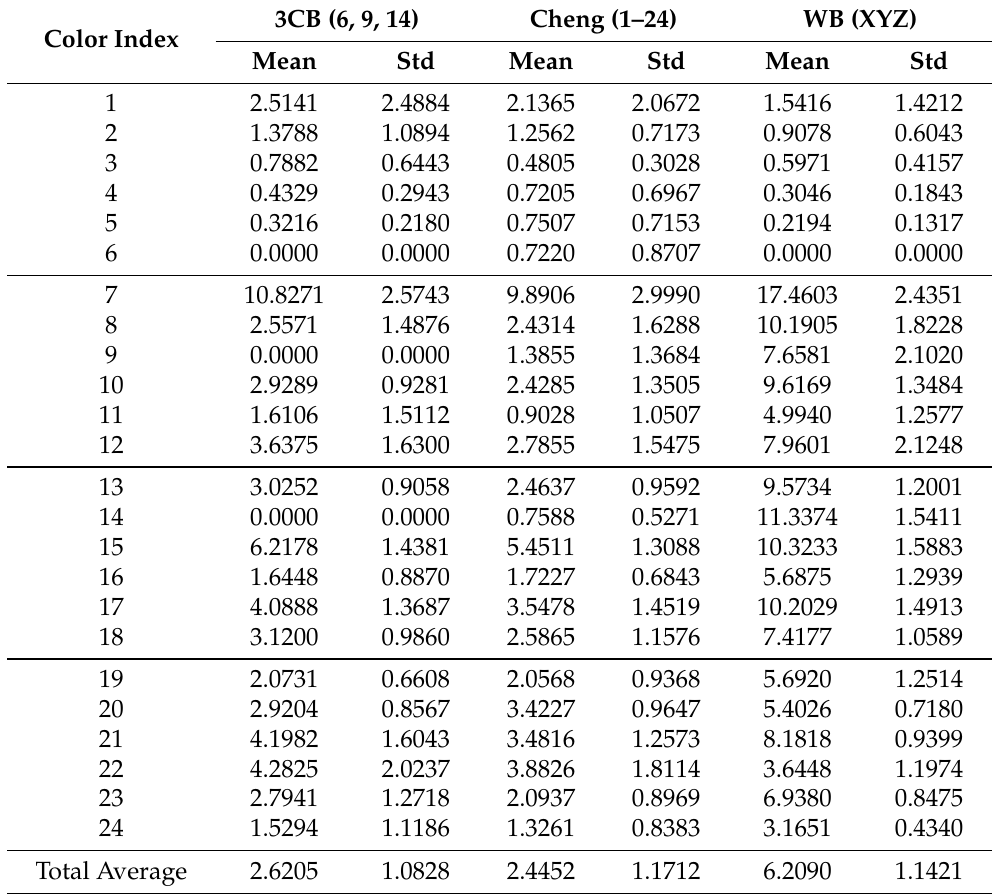
Table 1. Mean error (Mean) and standard variation (Std) of Err values for every patch (deg). Each color index corresponds to those of Figure 5.